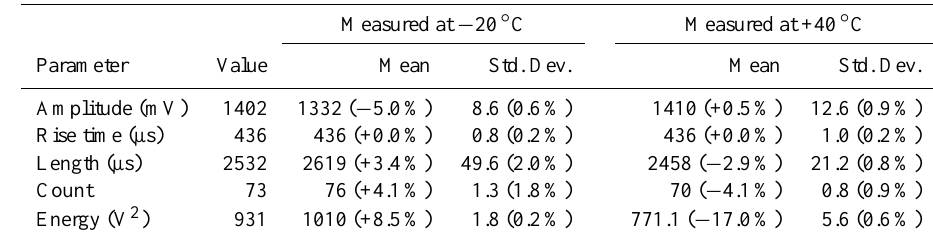
Table 2. Characteristics of the synthetic AE signal used to evaluate the AE-node performance, mean and standard deviation (Std. Dev.) of parameter values detected by the AE-node at − 20 ◦ C and +40 ◦ C.